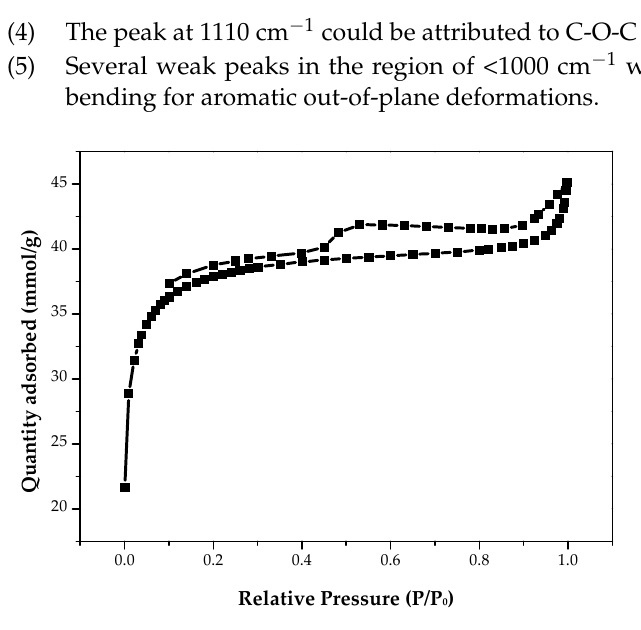
Figure 3. N 2 adsorption–desorption isotherms of the biochar product (PP-BC-900-20).